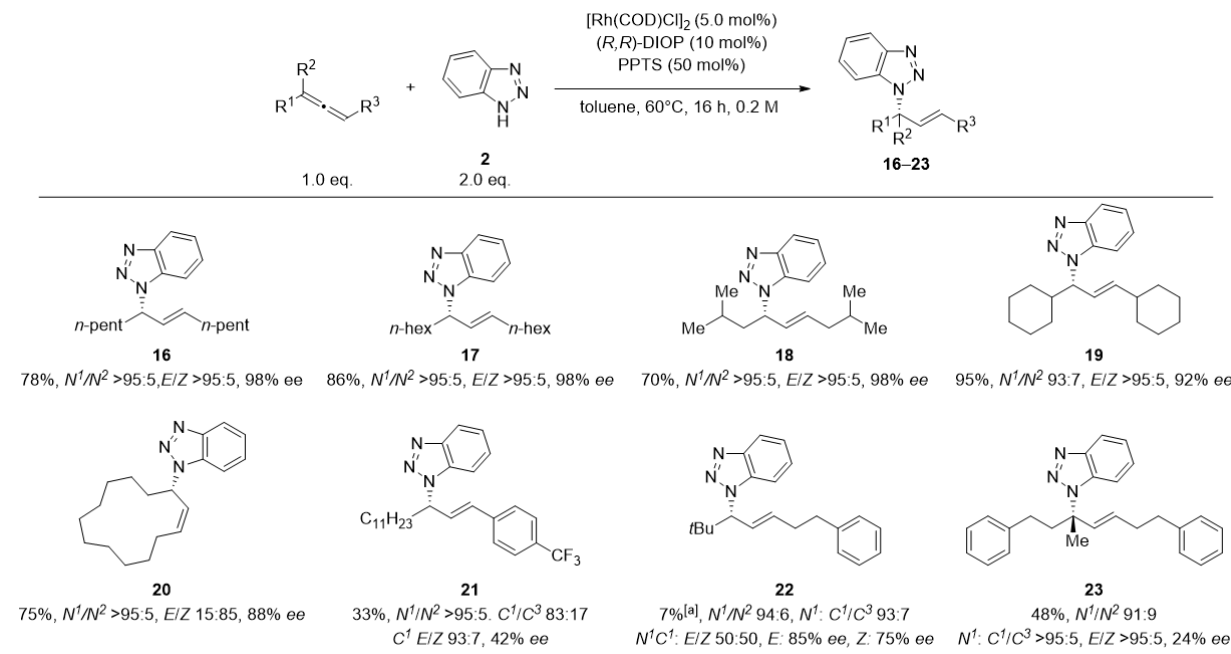
Figure 3. Scope of the addition of Benzotriazole ( 2 ) to different racemic allenes. Reactions were performed at 0.25 mmol scale. Cumulative yield for all isolated isomers. E/Z -selectivities determined by 1 H-NMR. Enantioselectivities were determined by HPLC analysis using a chiral stationary phase. Unless specified, ee -values refer to main-stereoisomer of the main-regioisomer. [a] Reaction was heated for 72 h.